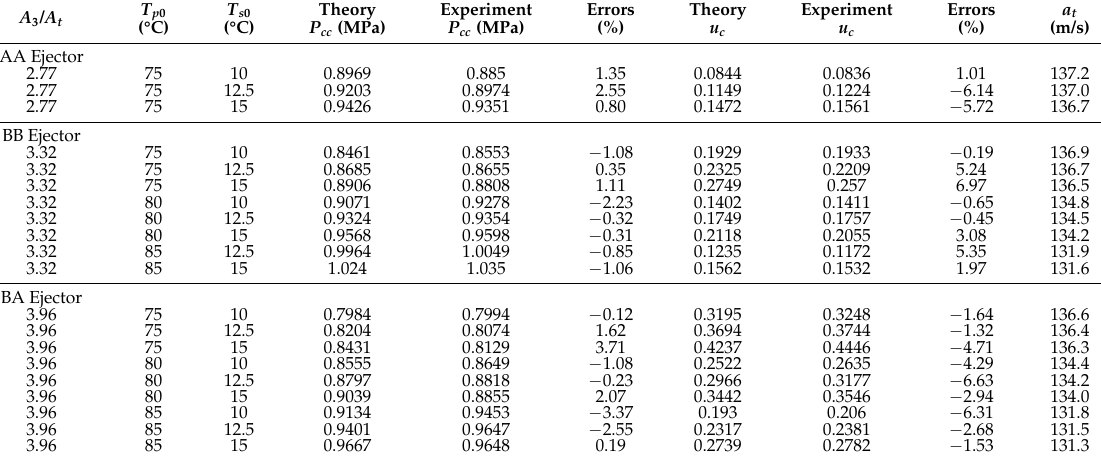
Table 2. Comparisons between critical point model and the experiment results for R134a ejectors.